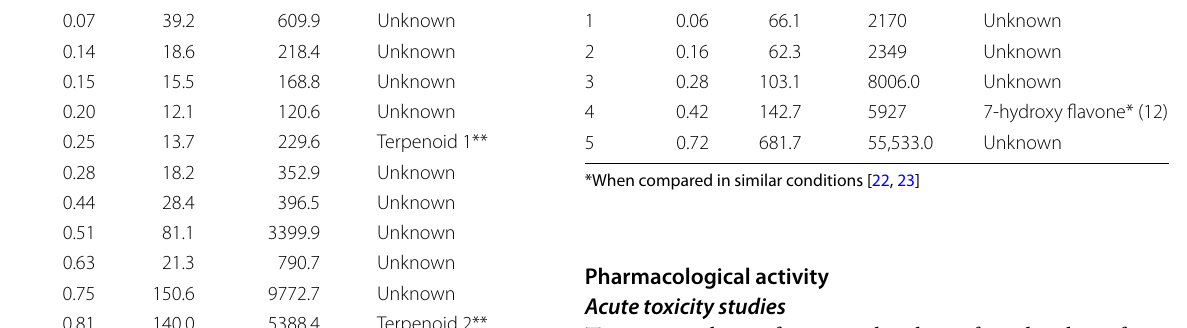
present, absent + = −= Table 8 Peak table of BPSAL in Mobile Phase I Peak